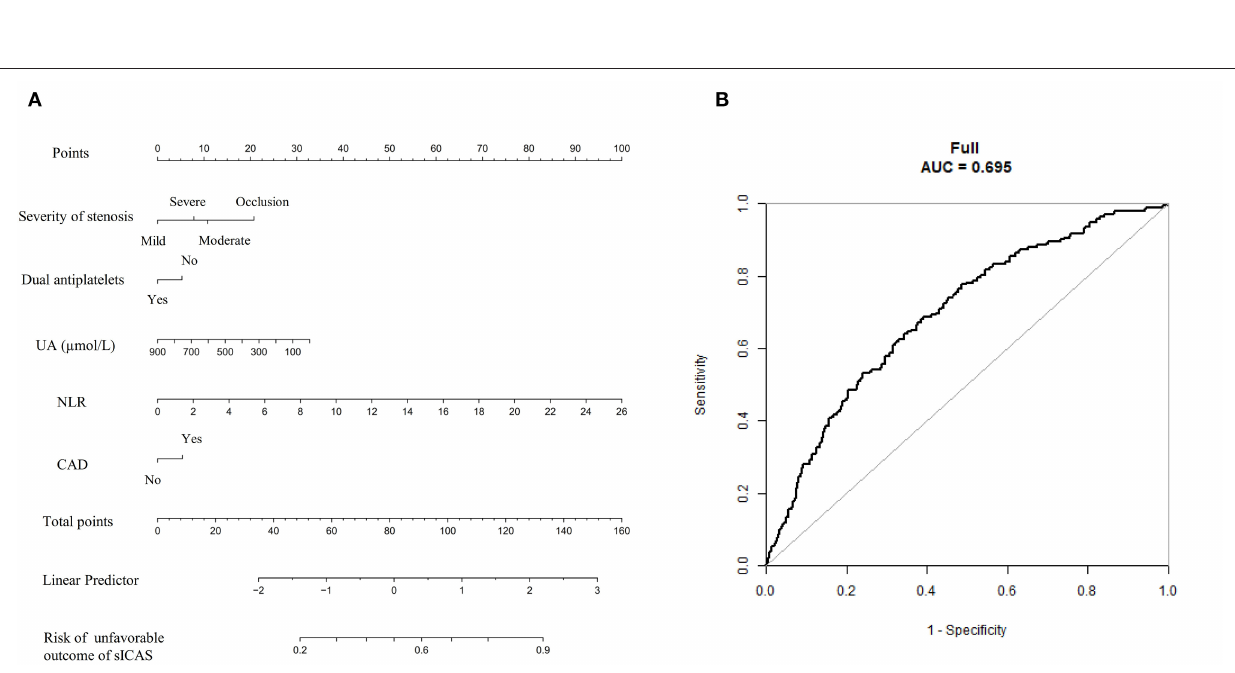
Frontiers in Neurology | www.frontiersin.org